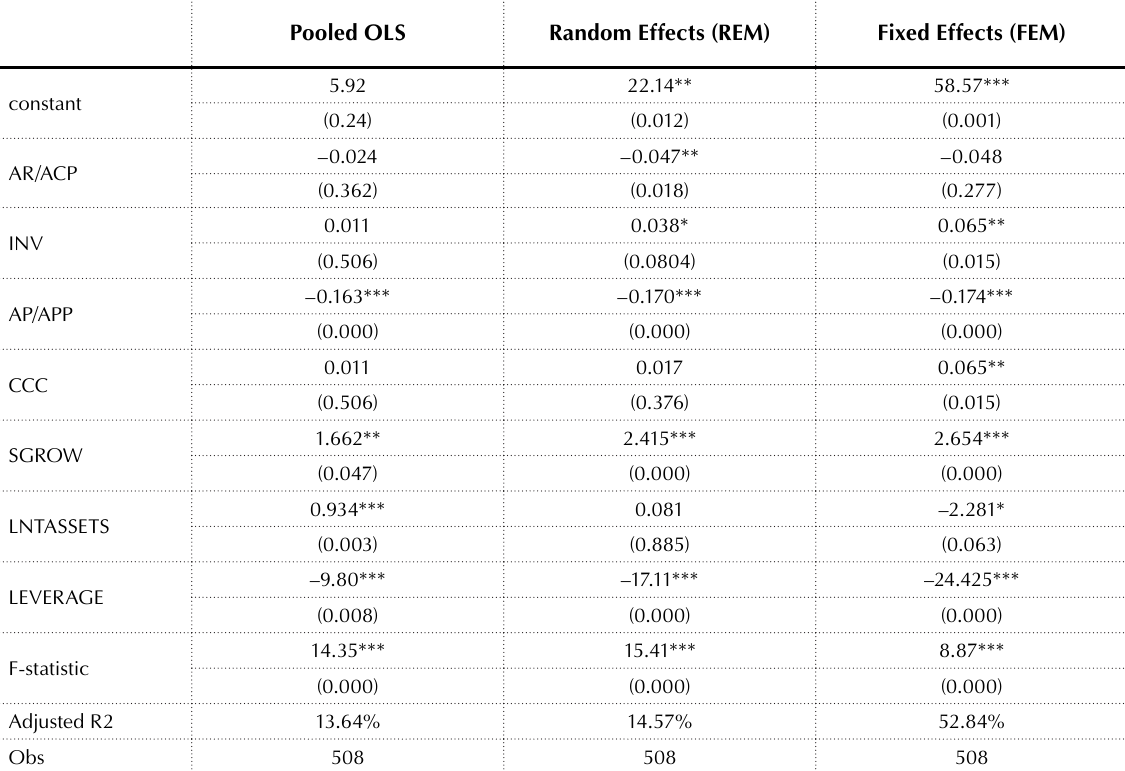
Table 4. Multivariate regression estimates using pooled OLS, REM and